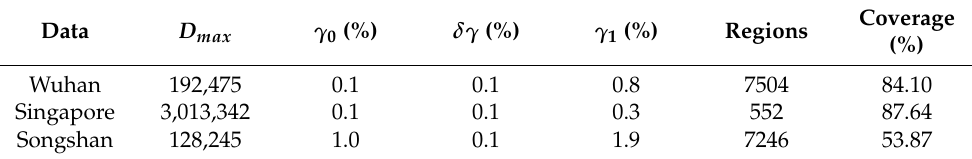
Table 1. Statistics of continuous region extraction on the experimental data.